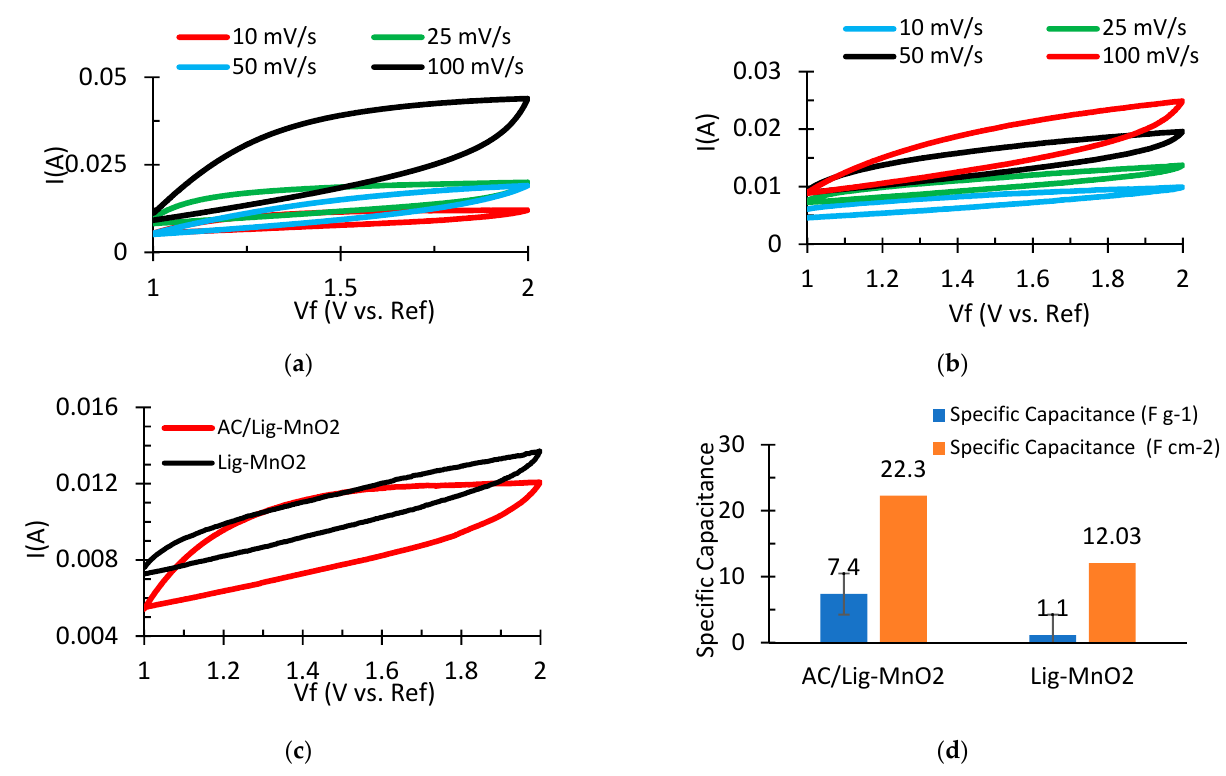
Figure 7. CV plots for ( a ) AC/Lig-MnO 2 , ( b ) Lig-MnO 2 at various scan rates, ( c ) comparison of CV plots of AC/Lig-MnO 2 and Lig-MnO 2 at 10 mV s − 1 , and ( d ) comparative histogram of specific capacitances.